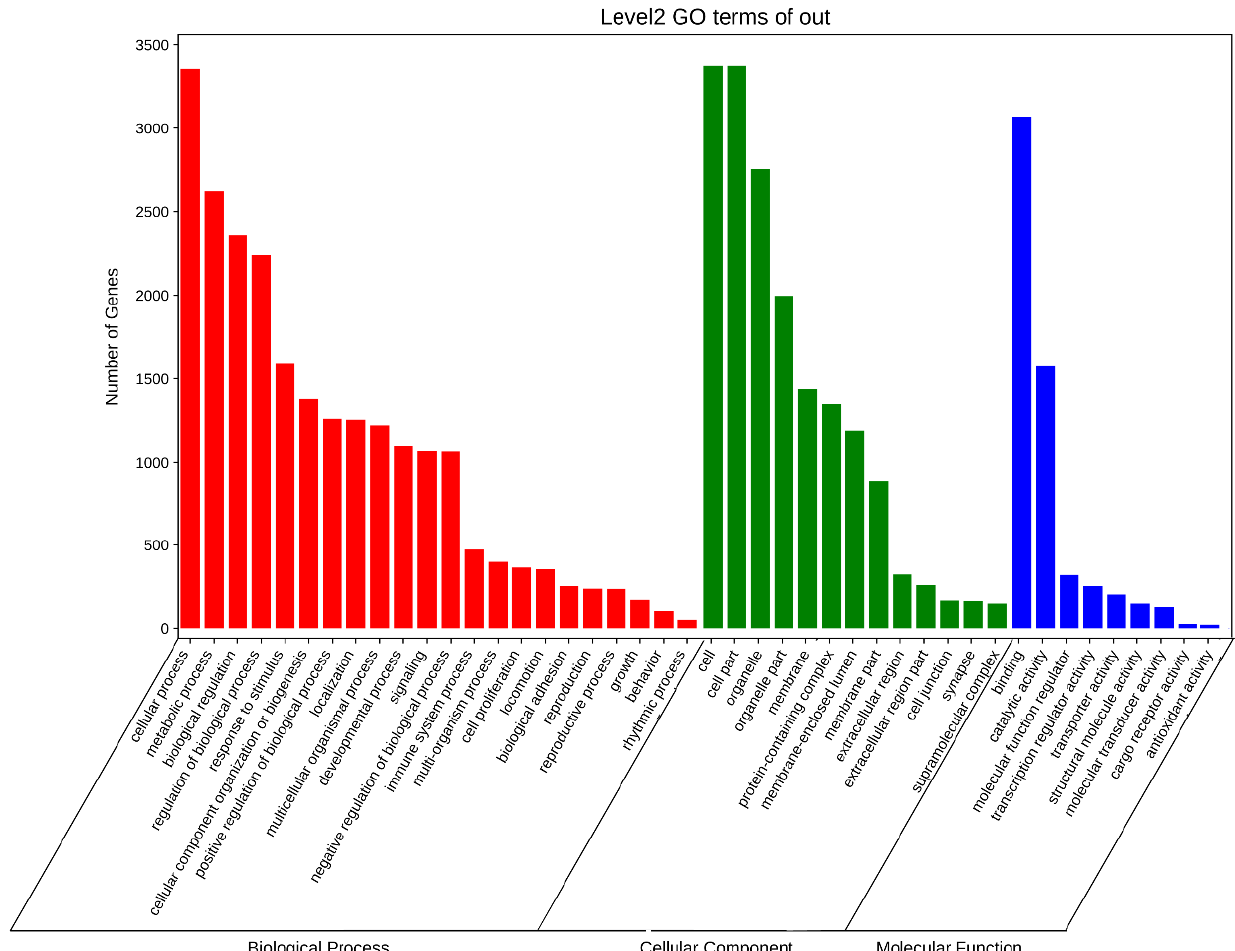
Figure 6. The GO enrichment analysis of genes in Sus scrofa. The genes whose PAS number are more than 2 (2 included) were selected to do enrichment tests in order to reveal the enrichment of gene ontology terms. Statistically significant molecular functions, biological processes, and pathways were identified. Each color block represents the gene amount in each